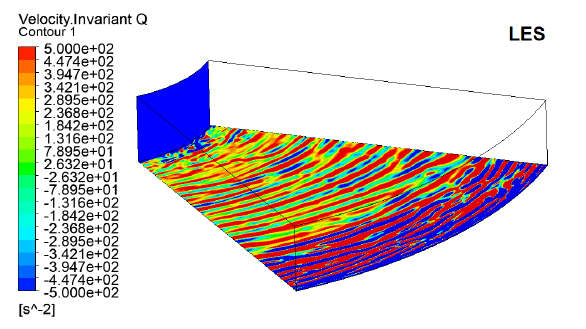
Fig. 4. Q-criterion: LES